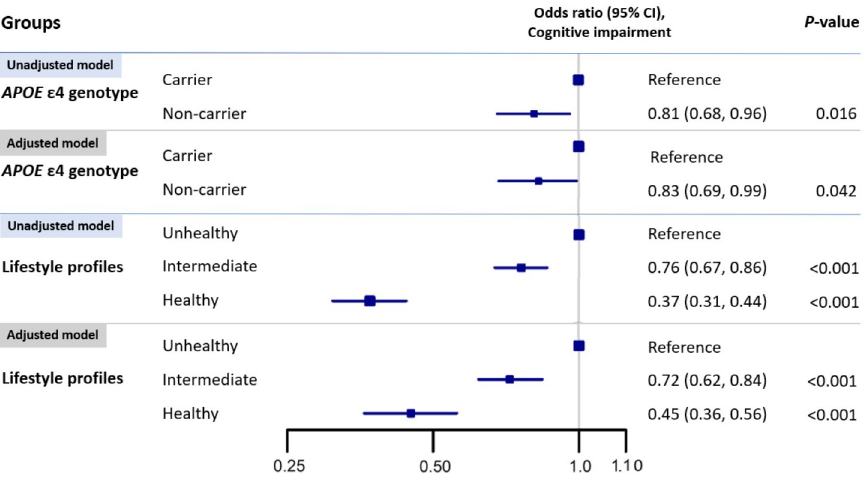
Fig 1. A AU : Pleasenotethatallinstancesofnon (cid:0) carrier ð s Þ havebeenreplacedwithnoncarrier ð s Þ throughoutthetexttoadheretoPLOSstyle : Also ; PLOSusesthetermPvalue ð withouthyphen Þ : Toobserveconsistency ; pleaseprovideupdatedFigs 1 and 2 fileswithNon (cid:0) carrier = non (cid:0) carrierreplacedwithNoncarrier = noncarrierandP (cid:0) valuereplacedwithPvalue : ssociations � of cognitive impairment �� with APOE ε 4 genotype and lifestyle profiles. � Model adjusted for age, sex, residence, education level, marital status, APOE genotype, lifestyle profile, activity of daily living, and 7 kinds of self-reported disease (COPD, tuberculosis, cancer, diabetes, hypertension, stroke, and cardiovascular disease). �� Cognitive impairment: cognitive impairment was defined by an MMSE score of less than 18. A AU : AbbreviationlistshavebeencompiledforthoseusedthroughoutFigs 1 and 2 : Pleaseverifythatallentriesarecorrect : POE , apolipoprotein E; CI, confidence interval; COPD, chronic obstructive pulmonary disease; MMSE, Mini-Mental State